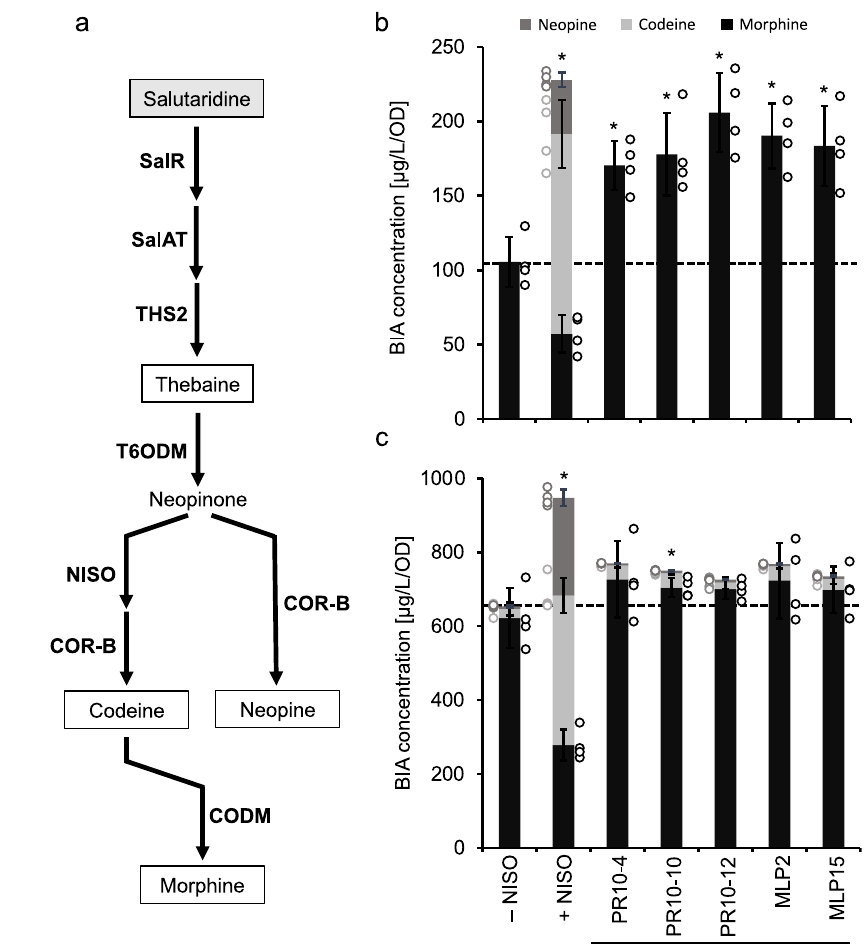
b Accumulation of morphine, codeine, and neopine in engineered yeast fed 50 µ M exogenous salutaridine for 2h. c Accumulation of morphine, codeine, and neopine in engineered yeast fed 50 µ M exogenous salutaridine for 6h. Bars represent the mean ± standard deviation of 4 biological replicates. Stacked bars show the mean levels of individual morphinan alkaloids ± standard deviation. Asterisks indicate a signi fi cantdifference( p <0.05;unpaired,two-tailed t